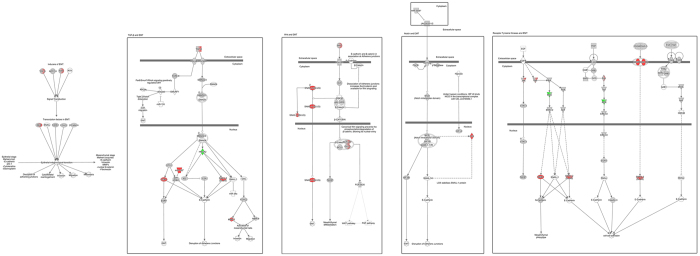
Epithelial-mesenchymal transition pathway, upregulated by L. plantarum TIFN 101 compared to placebo.Green and red coloured genes indicate down or upregulation, respectively. Grey indicates the regulation did not reach significance.